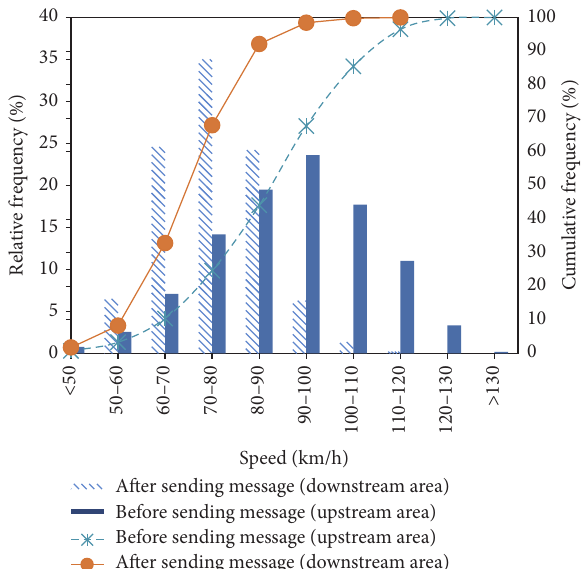
Figure 8: Relative and cumulative frequency distribution of speed in the status of sending a message.